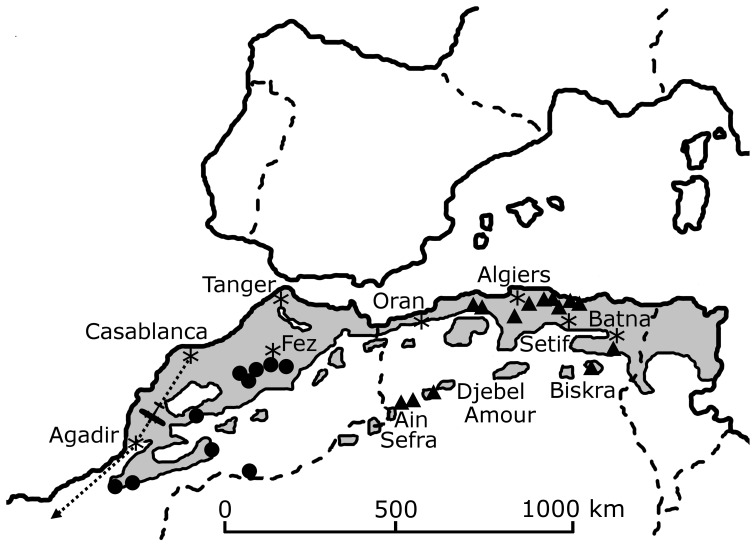
Distribution of recent sightings of lions in North Africa (AD 1900–1960).Grey shading indicates Mediterranean scrubland ecosystems [8]. Circular markers indicate sightings in western Maghreb (8–21 in Table 1); triangular markers indicate sightings in eastern Maghreb (134–149) from incidents described in Table 6. The dotted line indicates the air route across the Atlas Mountains (Casablanca-Agadir-Dakar) during which the last wild lion was photographed. Asterisks (*) denote locations of human population centers. Dashed lines indicate national boundaries.